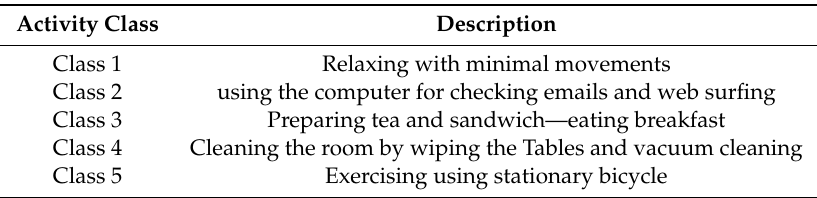
Table 1. Description of activity